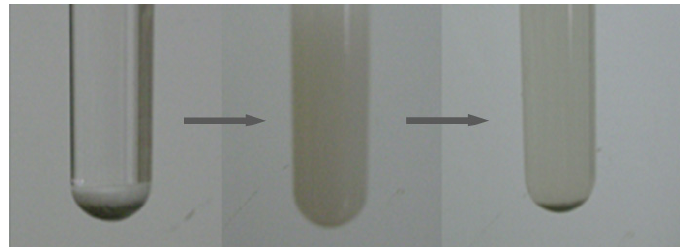
Figure 3. The conversion of fructose to 5 ‐ HMF over CePW 12 O 40 in sec ‐ butanol.